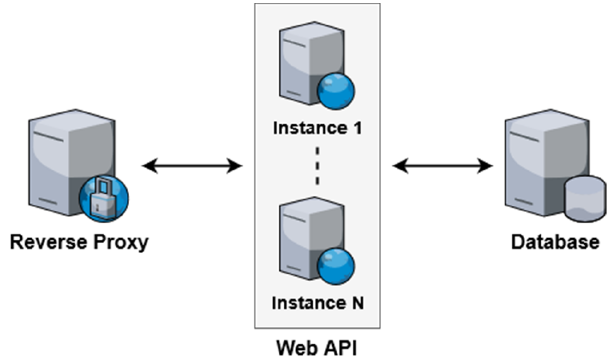
Figure 9. Test deployments for evaluation of horizontal scaling.